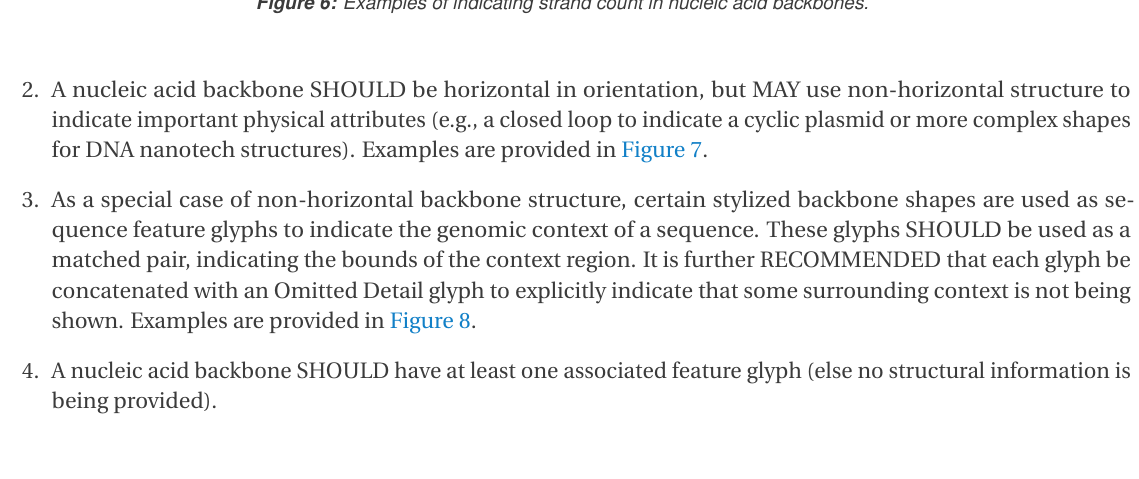
Figure 6: Examples of indicating strand count in nucleic acid